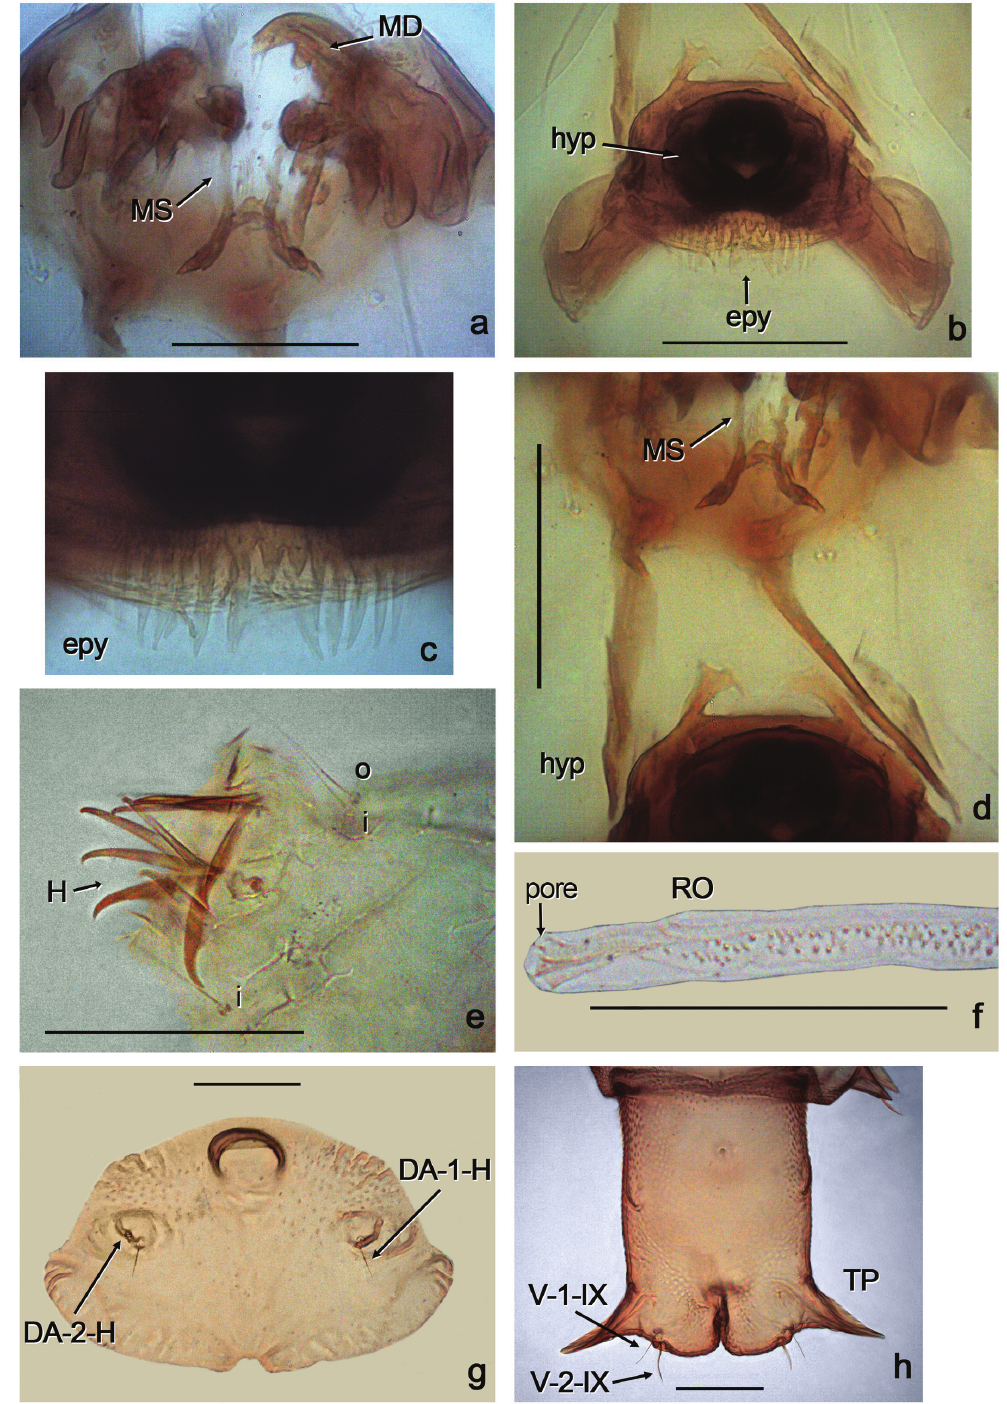
Figure 3a-h - Dasyhelea mediomunda Minaya, a-e larva, f male pupa, g-h female pupa; a , mandible and messors; b , epipharynx and hypopharynx; c , epypharynx; d , hypopharynx and messors; e , caudal segment; f, respiratory organ; g , dorsal apotome; h , segment 9. Dorsal apotome sensilla (DA-1-H, DA-2-H); epypharynx (epy); hypopharynx (hyp); hook (H); inner setae (i); mandible (MD); messors (MS); outer setae (o) respiratory organ (RO); terminal processes (TP); ventral sensilla of ninth abdominal segment (V-1-IX,